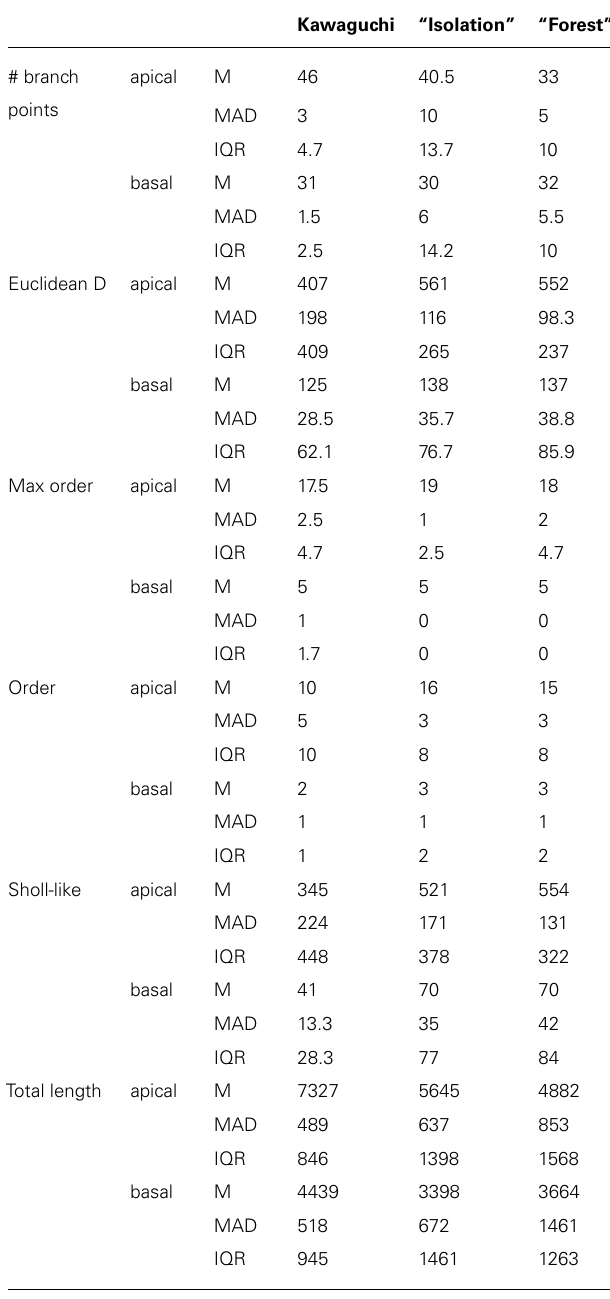
Table 6 | Quantitative description of experimentally reconstructed L5 pyramidal neurons and their generated counterparts. Kawaguchi “Isolation”